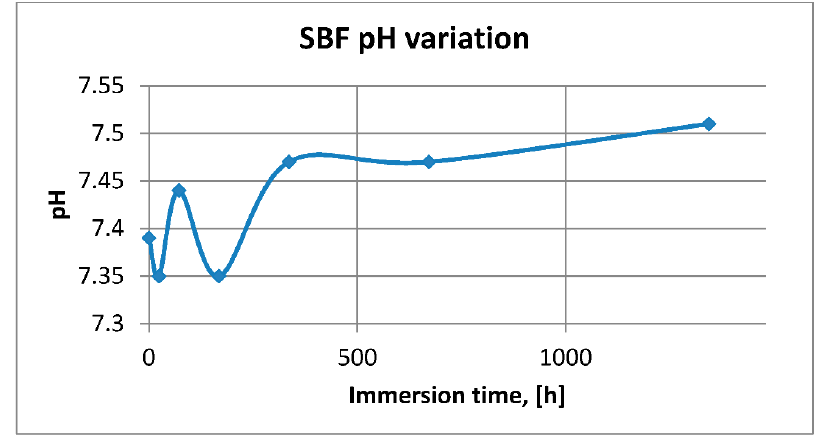
Figure 4. SBF pH vs. immersion time variation.